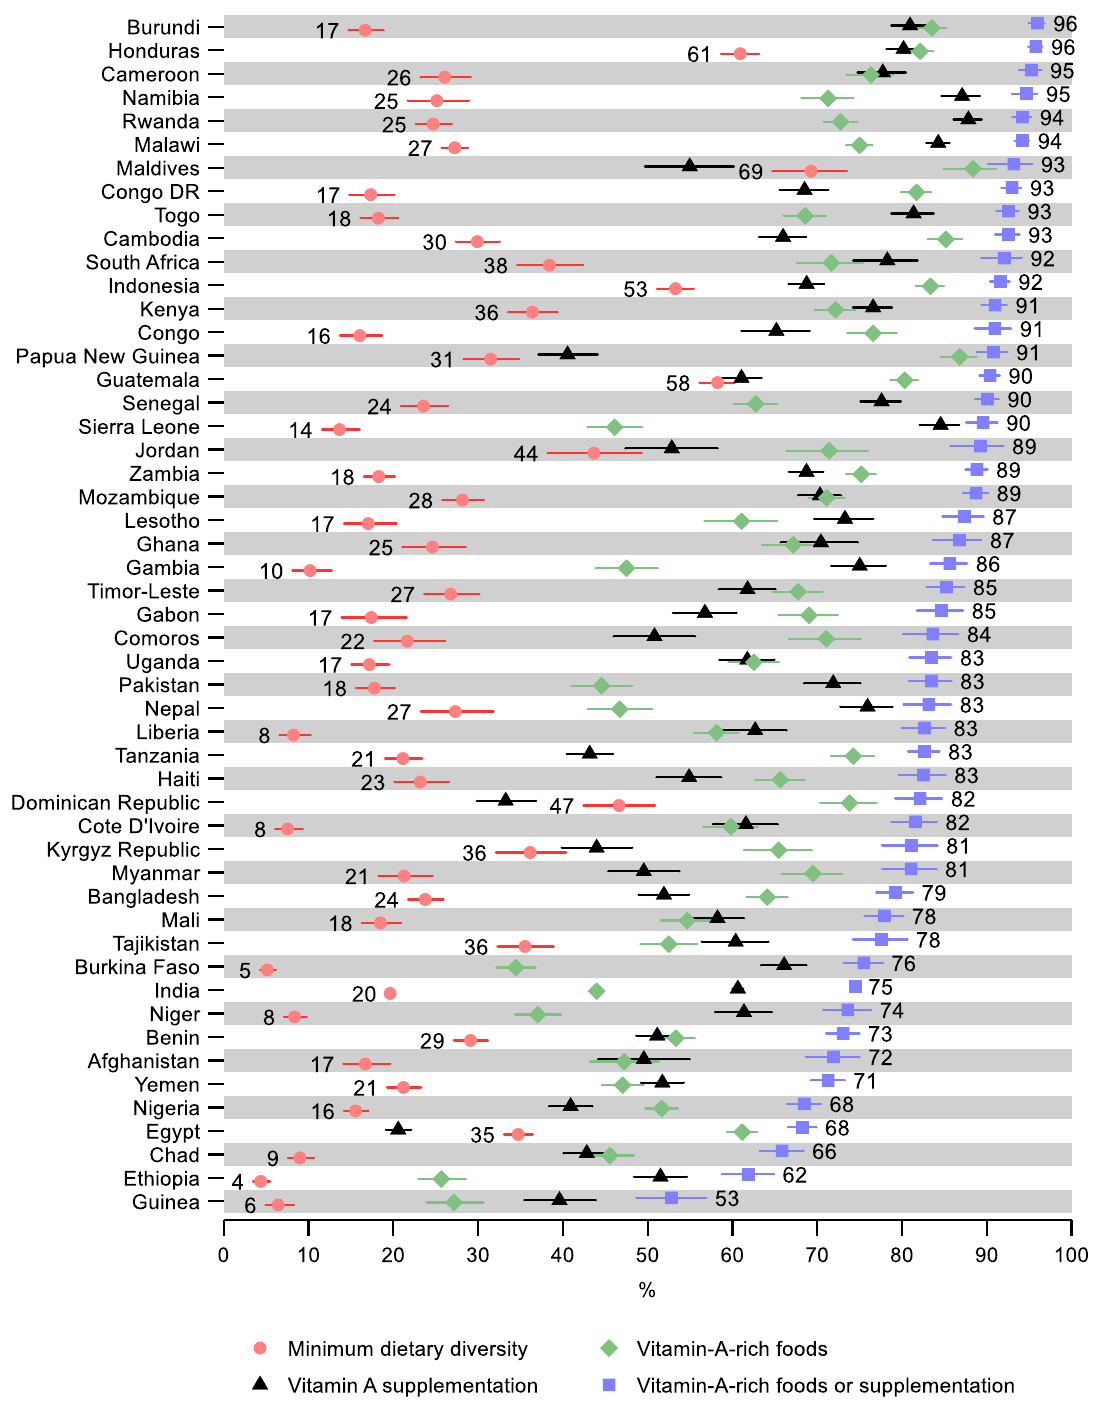
Figure 2. Percentage of children 6–23 months old that received the minimum dietary diversity, vitamin-A-rich foods, vitamin A supplementation, and either vitamin-A-rich foods or vitamin A supplementation by country. Notes: 95% confidence intervals are shown. Countries are ordered from largest to smallest percentage of children receiving either vitamin-A-rich foods or supplementation. Some confidence intervals may be narrower than the symbol for the estimate and therefore not visible. See Table S4 in the Supplement for the tabulated estimates and confidence intervals.